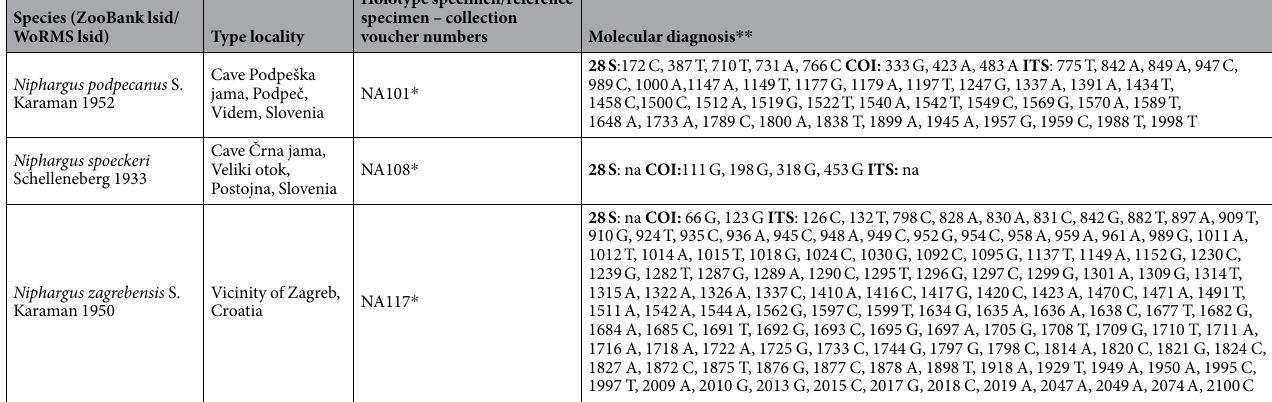
Table 2. Molecular diagnoses of species within the Niphargus stygius complex, including species redescriptions and newly described species. Voucher numbers refer either to specimens selected as reference specimens for previously described species or specimens selected as holotypes of newly described species. All specimens were deposited in the Zoological collection of the Department of Zoology. * Asterisk denotes reference specimens of species that were described before this study. ** - denotes gap in